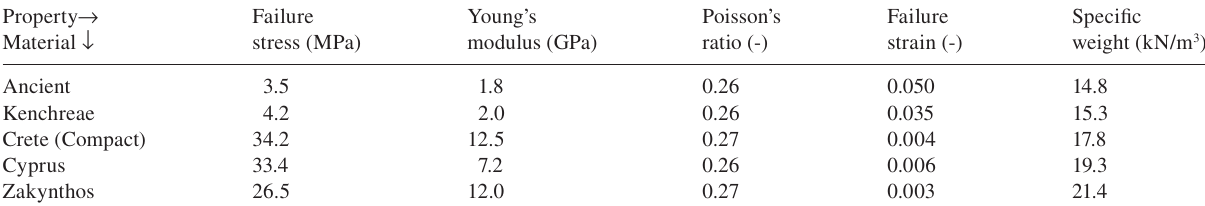
Table 3 Mechanical properties and constants of the ancient, authentic and substitute materials as obtained from quasi-static experiments. Property → Material